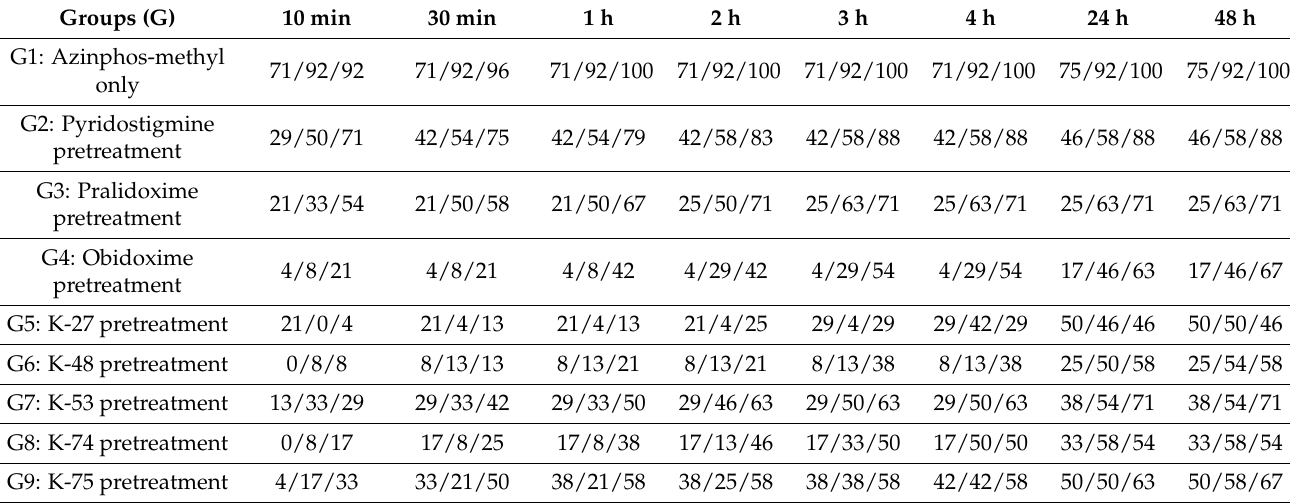
Table 2. Mortality of experimental animals exposed to intraperitoneal (i.p.) injections of azinphos-methyl in a dosage of 5 (first value), 10 (second value), or 15 µ mol (third value). Listed are the proportions of dead animals in percent at each time point (10 min, 30 min, 1 h, 2 h, 3 h, 4 h, 24 h, and 48 h after azinphos-methyl injection) for untreated rats (group 1, reference: azinphos-methyl only) and for animals pretreated with pyridostigmine, established oximes (pralidoxime, obidoxime), or experimental K-oximes (K-27, K-48, K-53, K-74, K-75) before azinphos-methyl exposure. The dose injected for pretreatment was approximately 1 of the LD 01 4